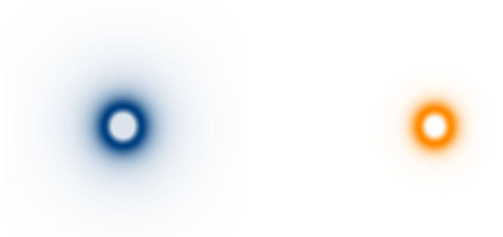
Fig. 17 The section passing through the center of the structure, repre- senting the electric field (left, blue) with e = 1 and the energy density (right, orange) associated to the model in Sect. 4.2.1 for σ = 5, α = 2 and k = 2. The intensity of the blue and orange colors increases with the increasing of the electric field and energy density, respectively